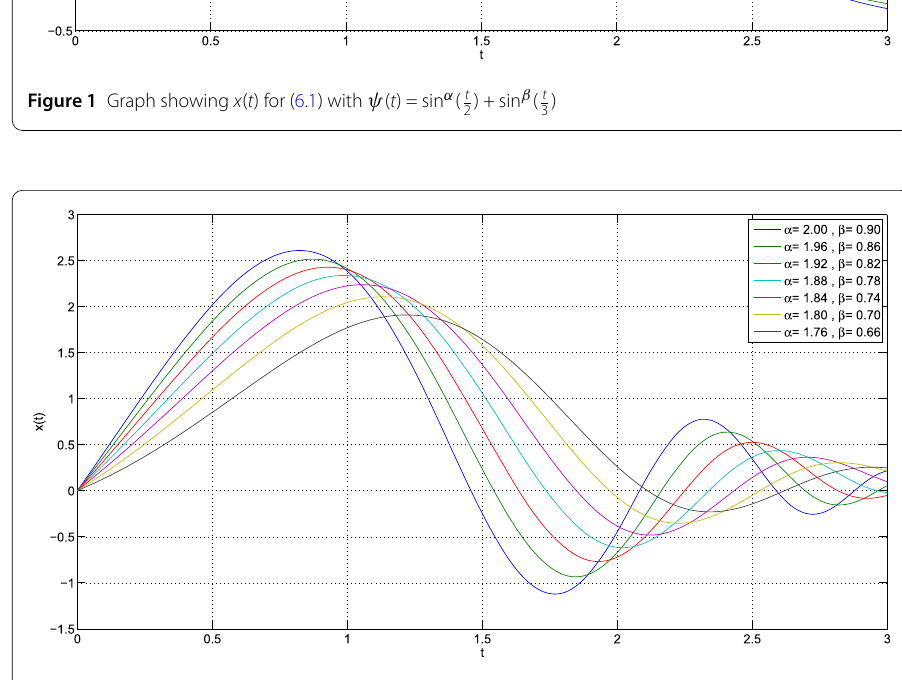
Figure 2 Graph showing x ( t ) for (6.1) via ψ ( t ) = α t + β